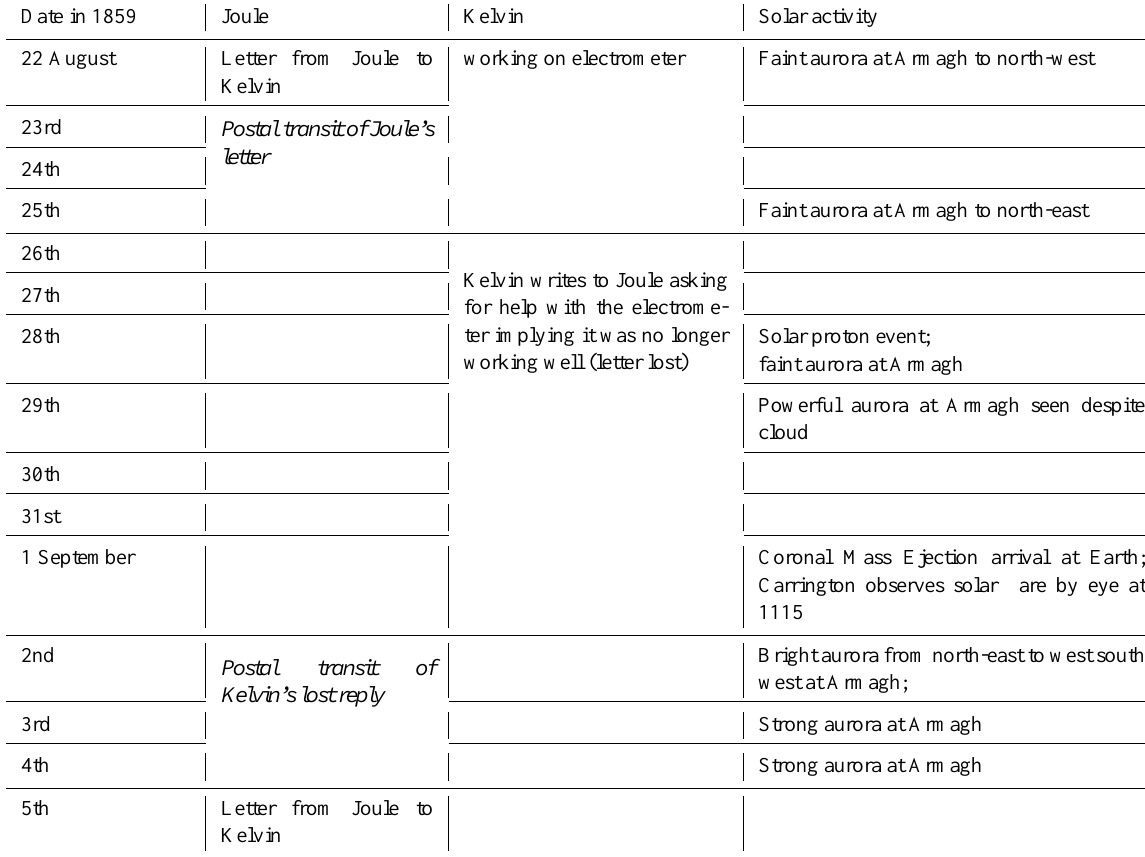
Table 2. Summary of Kelvin’s interaction with Joule during the Carrington flare period.